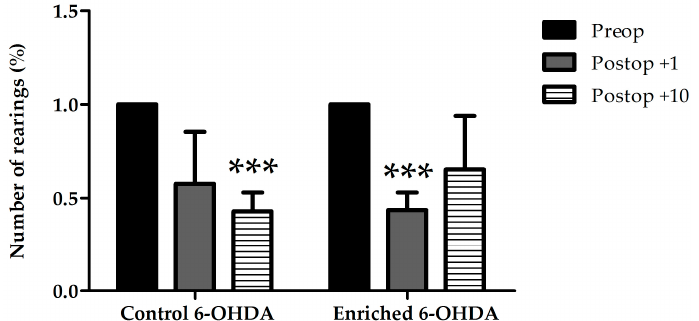
Figure 1. Rearing activity in 6-OHDA-treated control and enriched animal groups before (Preop), 1 day, and 10 days after the lesion (Postop +1, +10, respectively). In the graph the percentage of free rearings is shown compared to preoperative data of the same group. Values are given as mean ± S.E.M., where 100% = 1.0. *** p < 0.001 versus preoperative data of the same group.